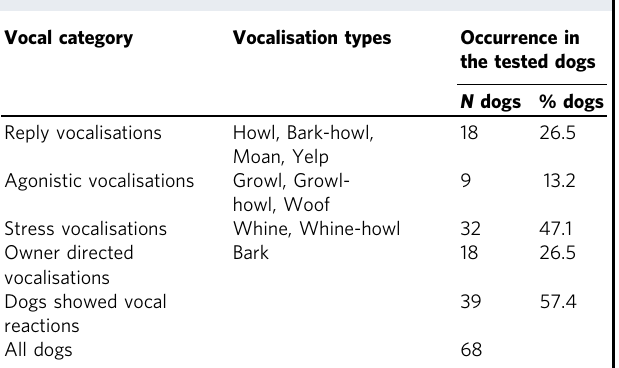
Table 2 Frequency of different vocal reactions.